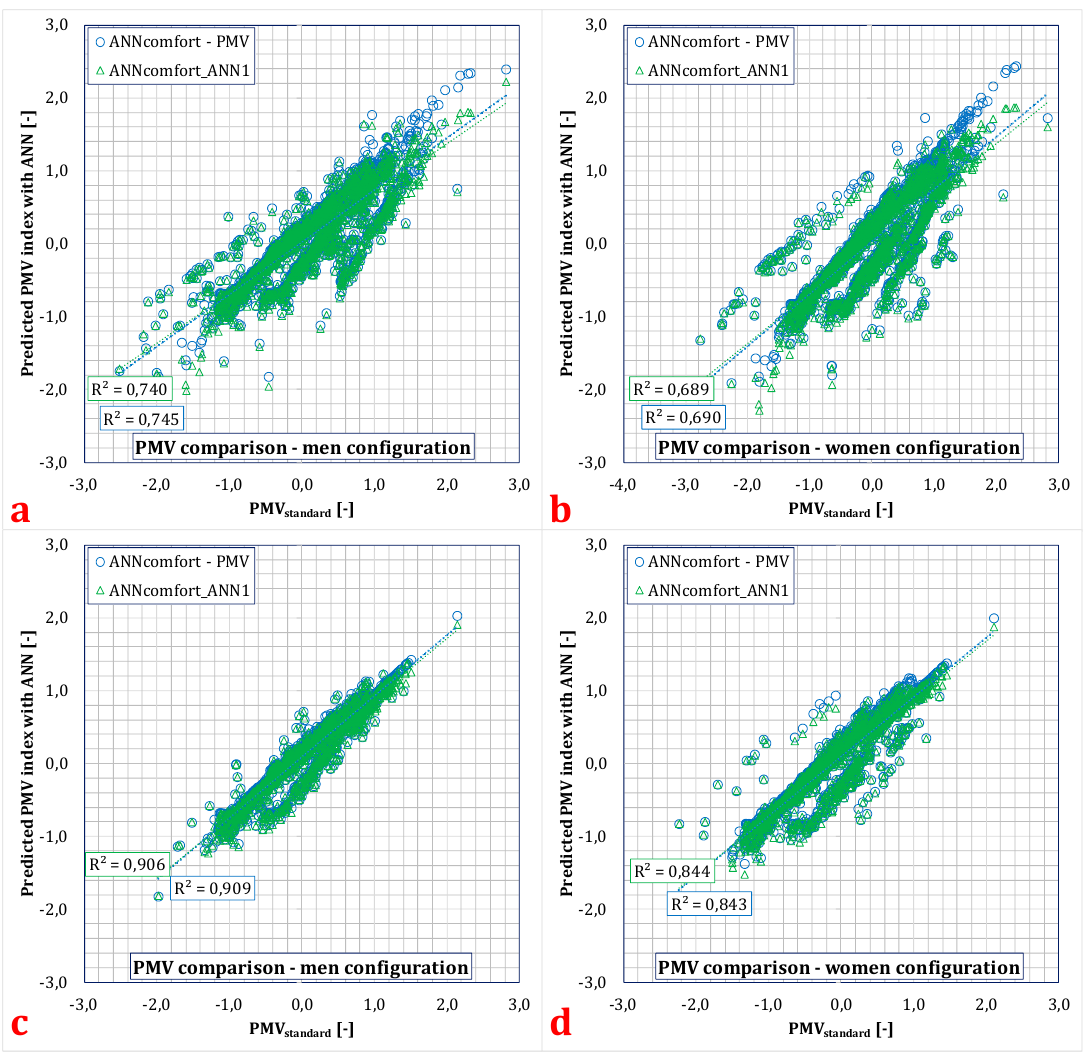
Figure 12. PMV comparison from ANNcomfort and ANNcomfort_ANN1 for men and women configurations: ( a ) and ( b ) related to range δ SD1 , ( c ) and ( d ) related to range δ SD2 .